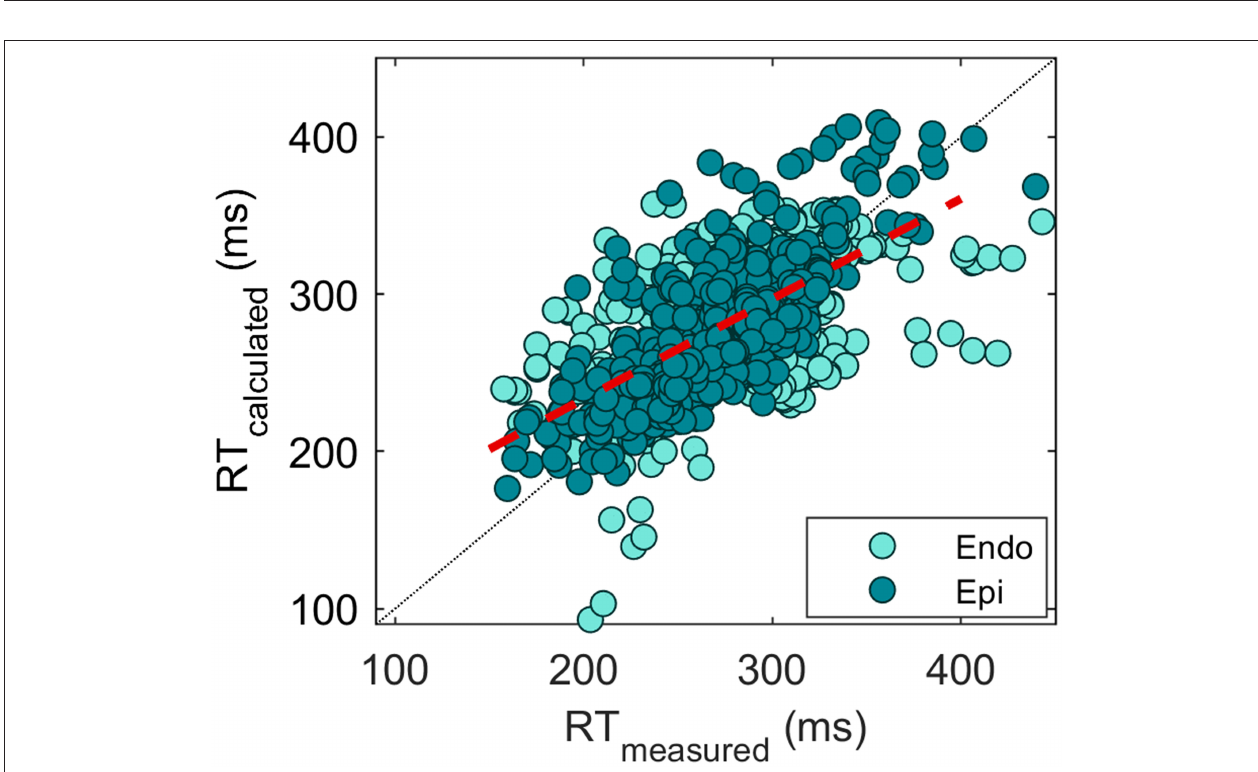
FIGURE 5 | Anterior views of reconstructed repolarization times for atrially paced beats in heart 2 with (B) and without (A) local pinacidil perfusion of the LAD region. The red dashed line indicates the estimated LAD perfusion area.